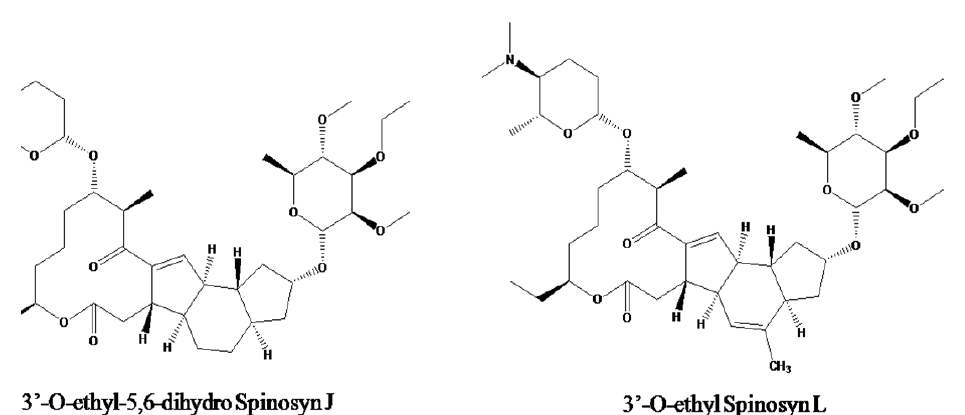
Figure 1. Chemical structures of 3 ′‐ O ‐ ethyl ‐ 5,6 ‐ dihydro Spinosyn J (XDE ‐ 175 ‐ J) and 3 ′‐ O ‐ ethyl Spinosyn L (XDE ‐ 175 ‐ L).